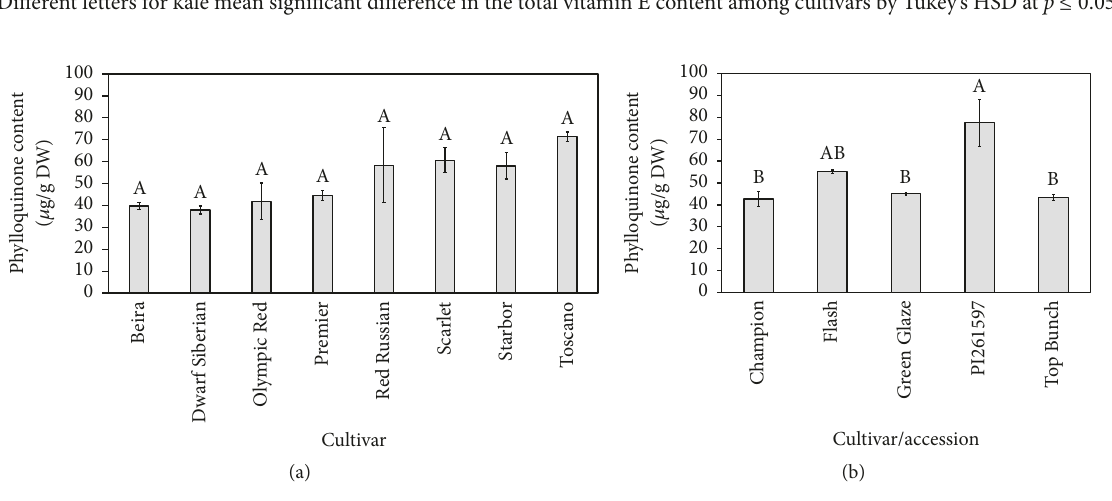
Figure 3: Phylloquinone (vitamin K 1 ) content in kale (a) and collard (b). Data are shown as mean ± standard error ( 𝑛 = 3 ). Phylloquinone content in kale was not different among cultivars of kale. Different letters for collard mean significant difference among cultivars by Tukey’s HSD at p ≤